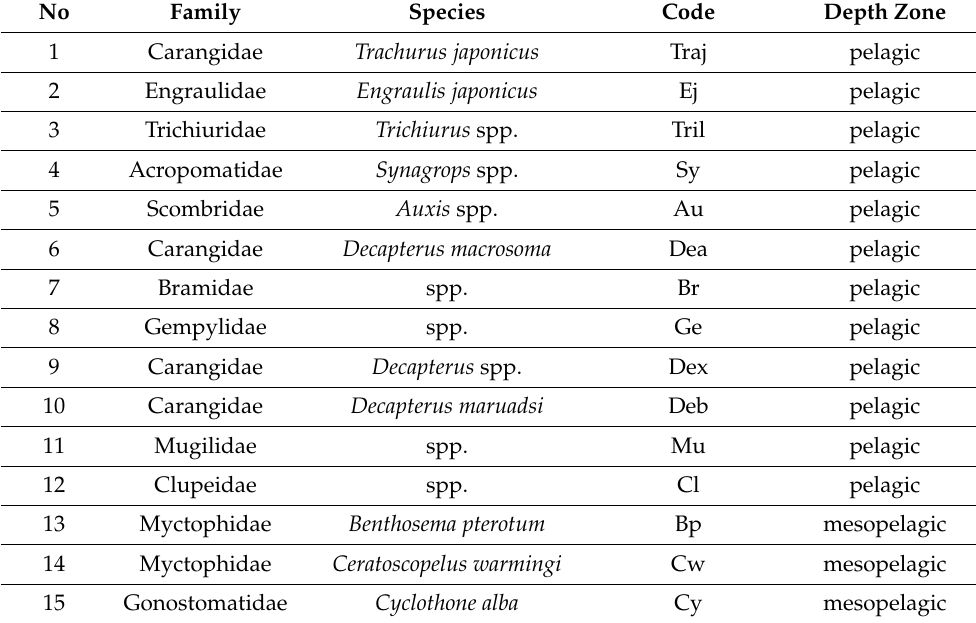
Table 1. Codes and habitat depth zones of 38 major species of fish (larvae and juveniles) in the waters around Taiwan from 2007 to 2019. The depth zones of different fish species are listed accord- ing to the classification methods of Sassa and Konishi [25] and Chen, Chen, Wang and Lee [13].